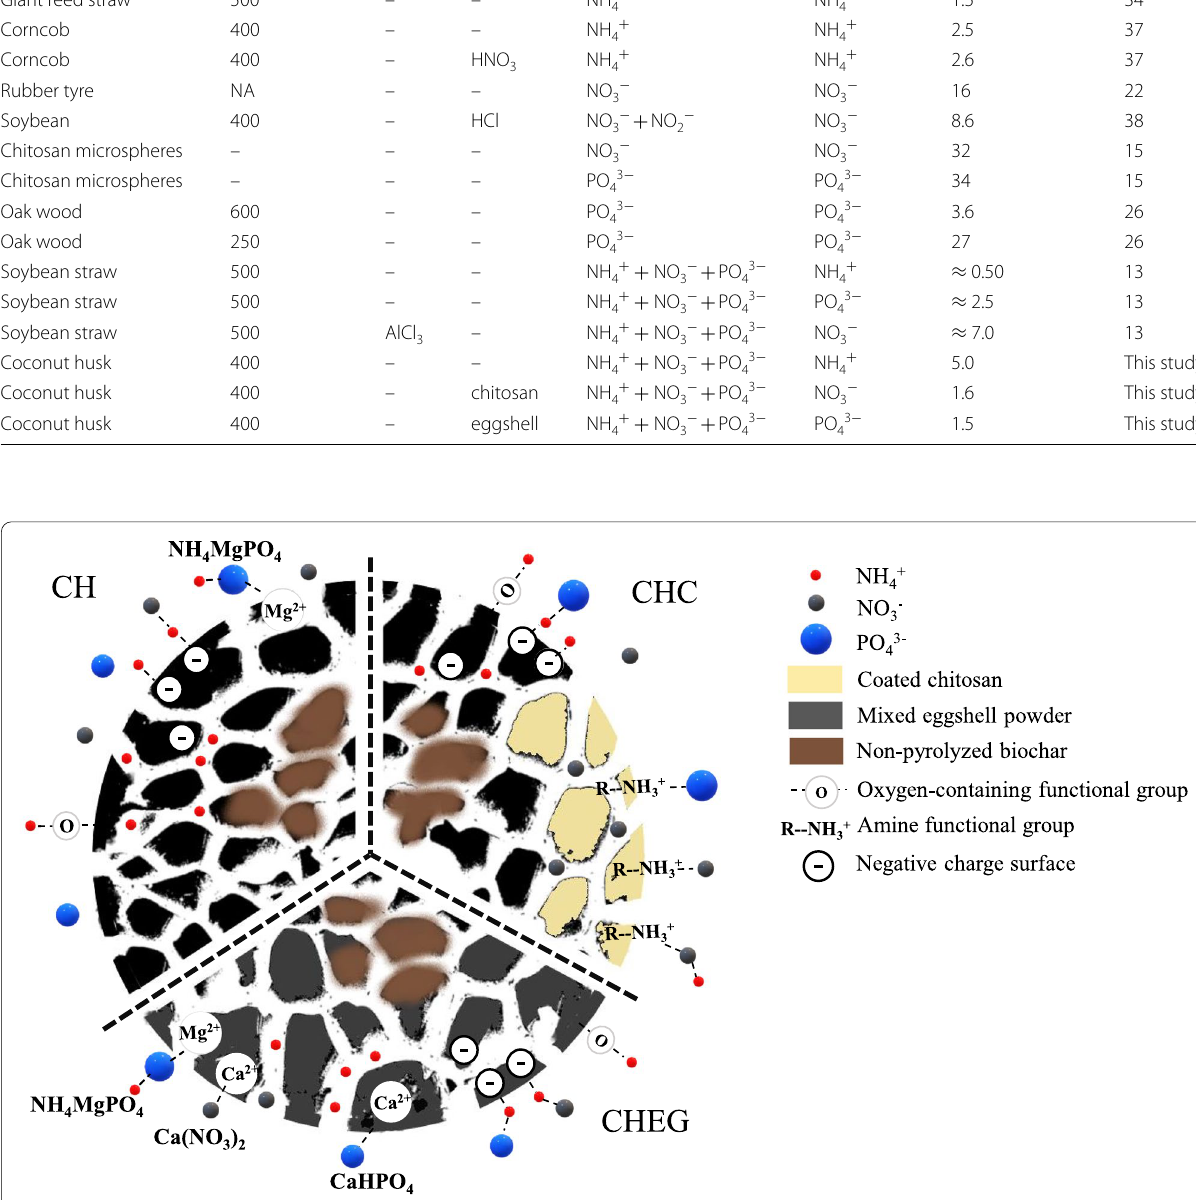
Fig. 8 Diagram of nutrient adsorption mechanisms on surfaces of biochar pellets in mixed solute